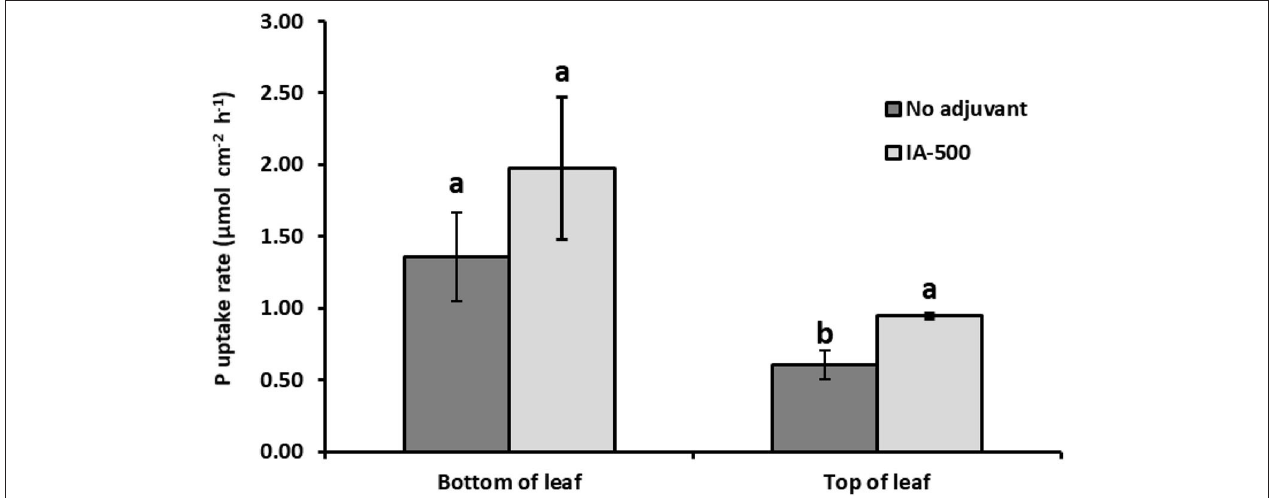
FIGURE 2 | Effect of the adjuvant IA-500 upon the uptake rate of foliar P into Triticum aestivum leaves in photosynthetic light. Average uptake rates into the whole plant of 33 P after application to a 16 mm 2 area of either the bottom or top surface of one leaf over 16h. Treatments incorporated either no adjuvant (dark bars) or 0.1% v/v IA-500 (light bars). n = 5 for each treatment, lower case letters mark values significantly different from each other at the p < 0.05 level (two-way ANOVA). Error bars are standard errors of the mean